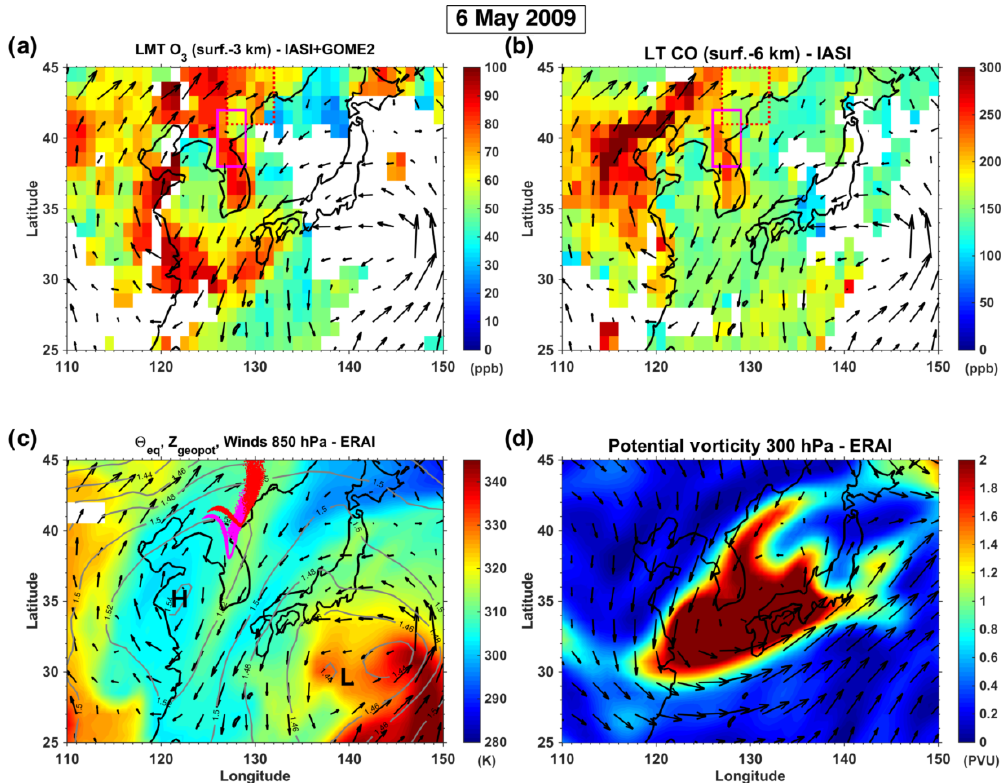
Figure 9. Same as Fig. 7 but for 6 May 2009. In panels (a) and (b) , magenta and dotted red squares show the main location of the southern and northern pollution filaments respectively. Dots in panel (c) indicate the location of the air parcels tracked with the HYSPLIT dispersion model, in magenta and red (southern and northern pollution plumes